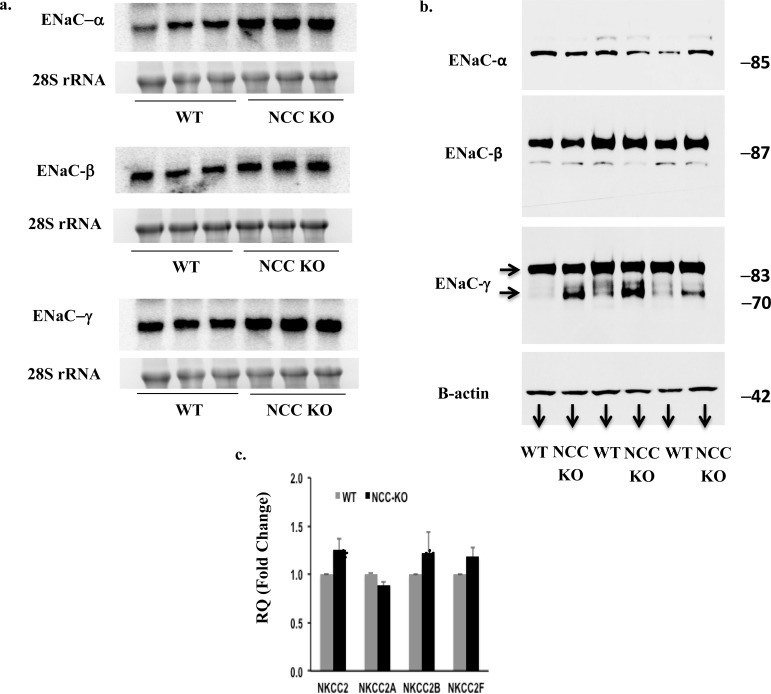
Expression of ENaC in kidneys of WT and NCC KO mice.Expression of ENaC subunits by (a) Northern hybridization and (b). Western blot in kidneys of WT and NCC KO mice. (a) Expression levels of all 3 subunits increased by Northern hybridization, with α, β and γ subunits increasing by 110, 80 and 70%, respectively, vs. wt littermates. Western blots show significant increase in the cleaved ENaC γ subunit in NCC KO mice, consistent with published reports (29). (b) The abundance of cleaved ENaC γ subunit form increased by ~420% in NCC KO mice. The full length bands for α, β and γ subunits are shown, which did not show significant changes vs. WT mice. c. Expression of NKCC2 isotypes in WT and NCC KO mice.